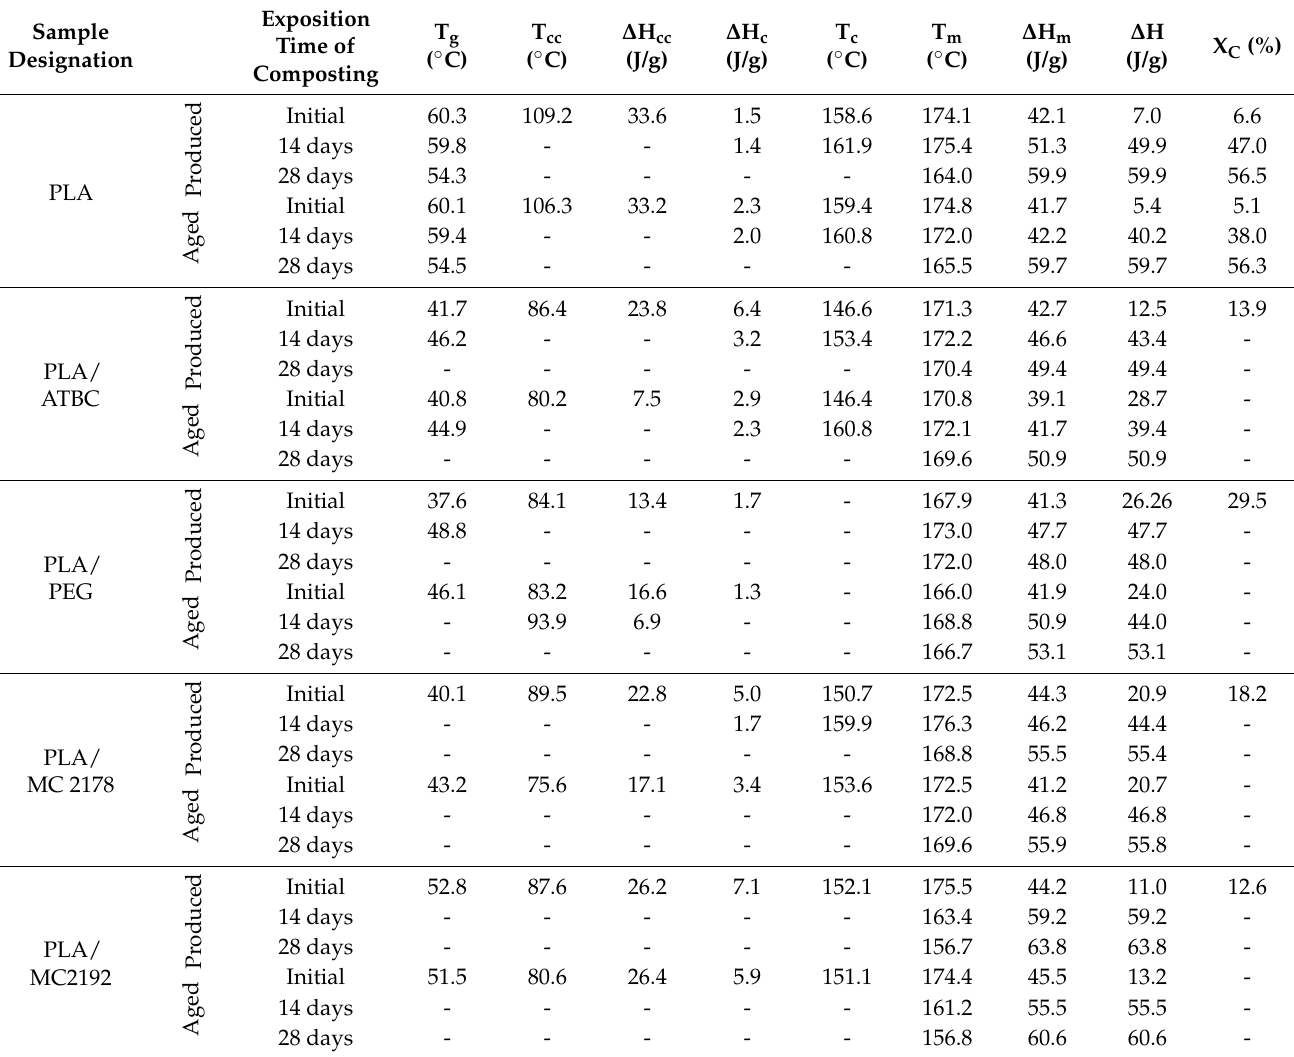
Table 4. DSC data of neat and plasticized PLA films after production, accelerated ageing, and composting